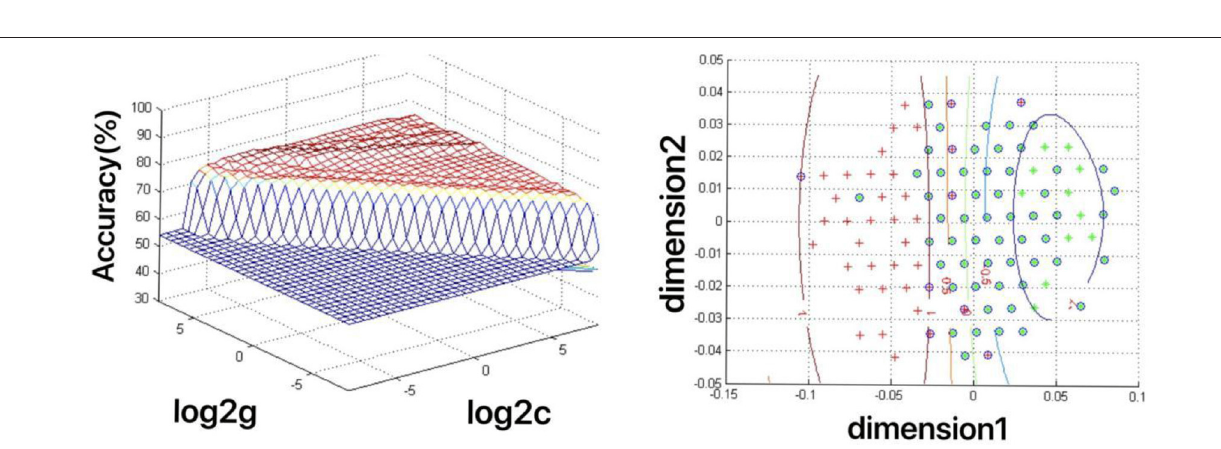
FIGURE 3 | Depiction of classifications based on the support vector machine (SVM) method using a combination of fractional amplitude of low-frequency fluctuation (fALFF) values in the right precuneus and left SFG to differentiate the first-episode major depressive disorder (MDD) patients from the healthy controls. Left: SVM parameters result of 3D view. g means gamma, c means penalty coefficient. Right: dimension 1 and dimension 2 represent the fALFF values in the right precuneus and left SFG, respectively. Green crosses represent the first-episode MDD patients, and the red crosses represent the healthy